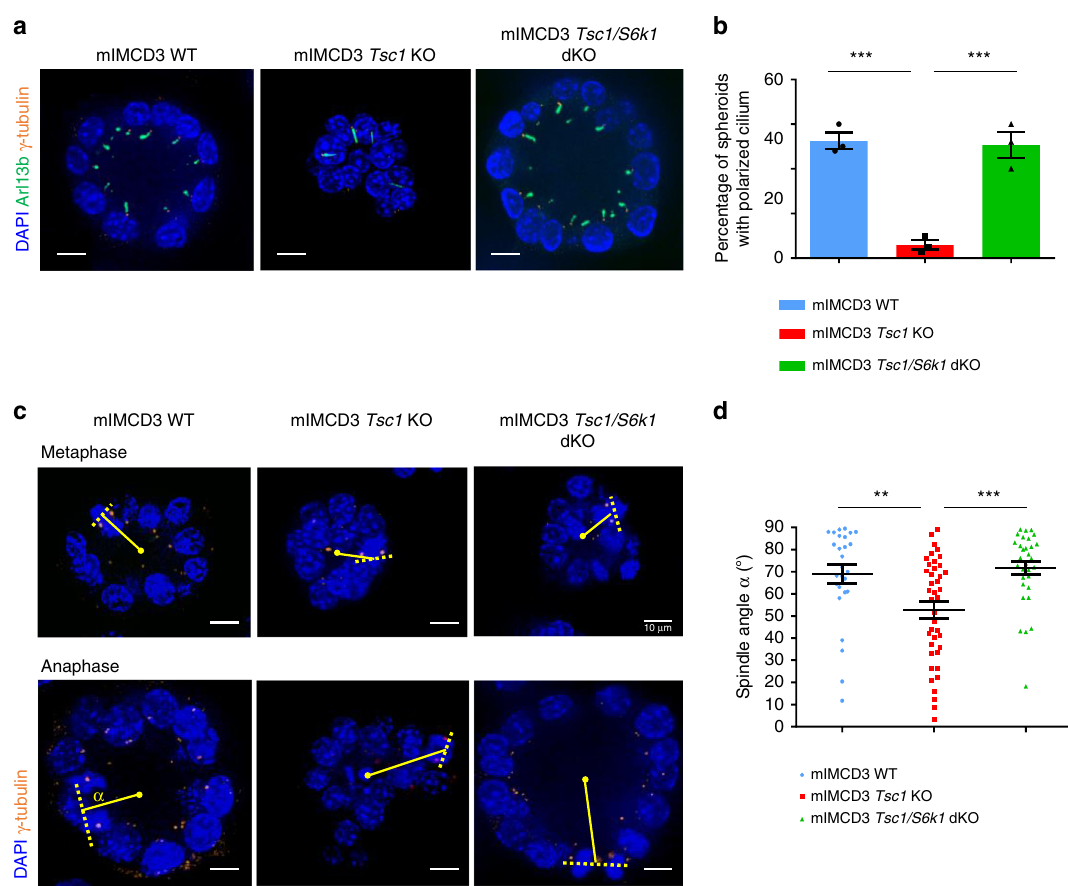
Fig. 4 Hyperactive S6K1 affects spindle orientation in sphere assays in vitro. a Representative images of 5-day mIMCD3s spheres immunolabeled with γ -Tubulin, Arl13b, and DAPI to quantify spheres with polarized centrosomes and primary cilia. Only spheres with a visible lumen and with all the centrosomes and primary cilia correctly localized on the luminal (apical) side were considered as normal. Scale bar, 10 µ m. b Quanti fi cation of the percentage of spheres with polarized primary cilia on total number of spheres per genotype. The ratio was calculated on n = 70 spheres per experiment. The histograms are an average of three independent experiments. Mean± SEM. c Representative images of 5-day mIMCD3s spheres immunolabeled with γ -tubulin and DAPI to measure spindle orientation. Yellow dotted lines indicate the spindle vectors, solid lines indicate the radius. Scale bar, 10 µ m. d Quanti fi cation of spindle angles relative to the apical-basal axis in 5-day spheres. Each dot represents a mitotic event, three independent experiments were analyzed. Horizontal lines represent the mean ± SEM. Source data are provided as a Source Data fi